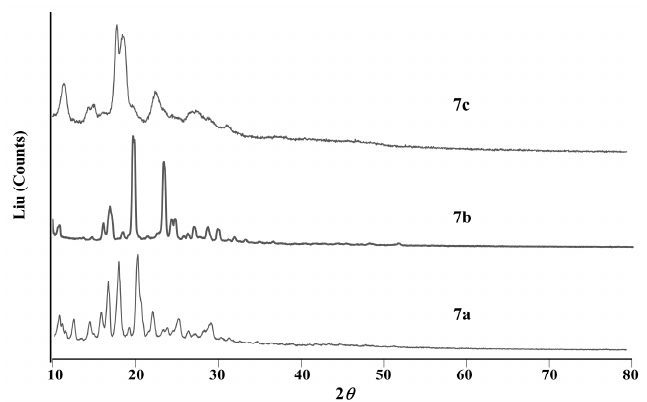
Figure 3. X-ray diffractograms of compounds 7a , 7b , and 7c in powder state.